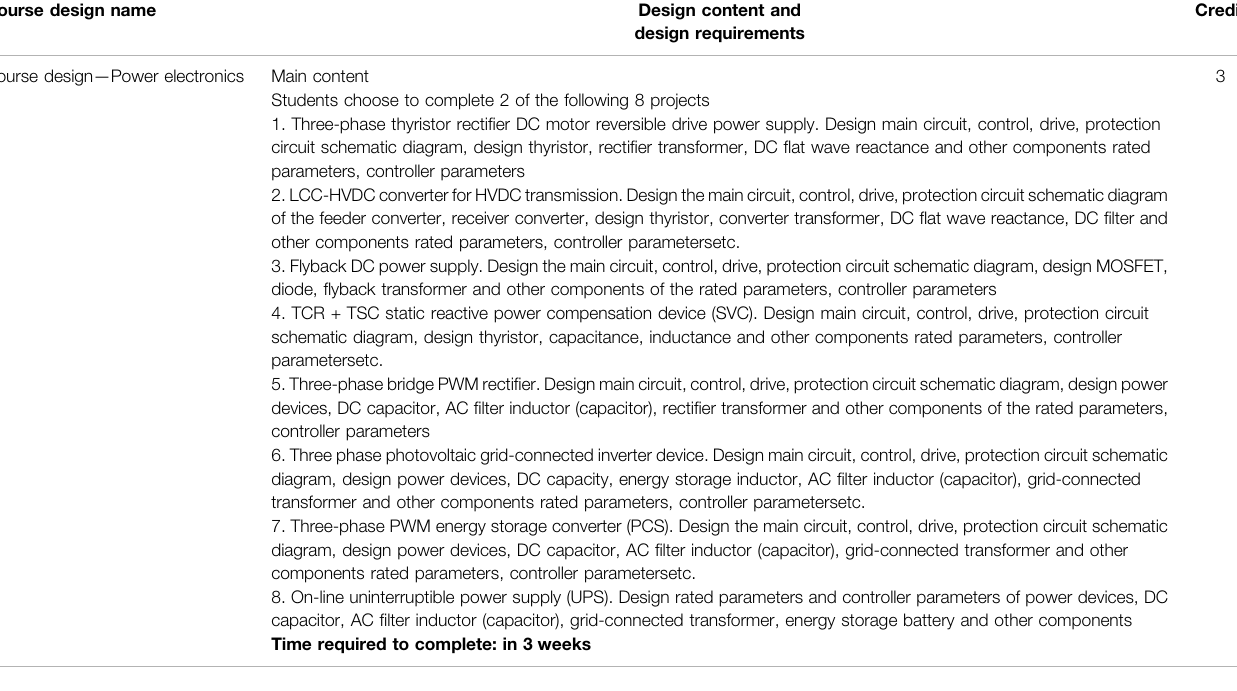
TABLE 6 | New course design — Power electronics.